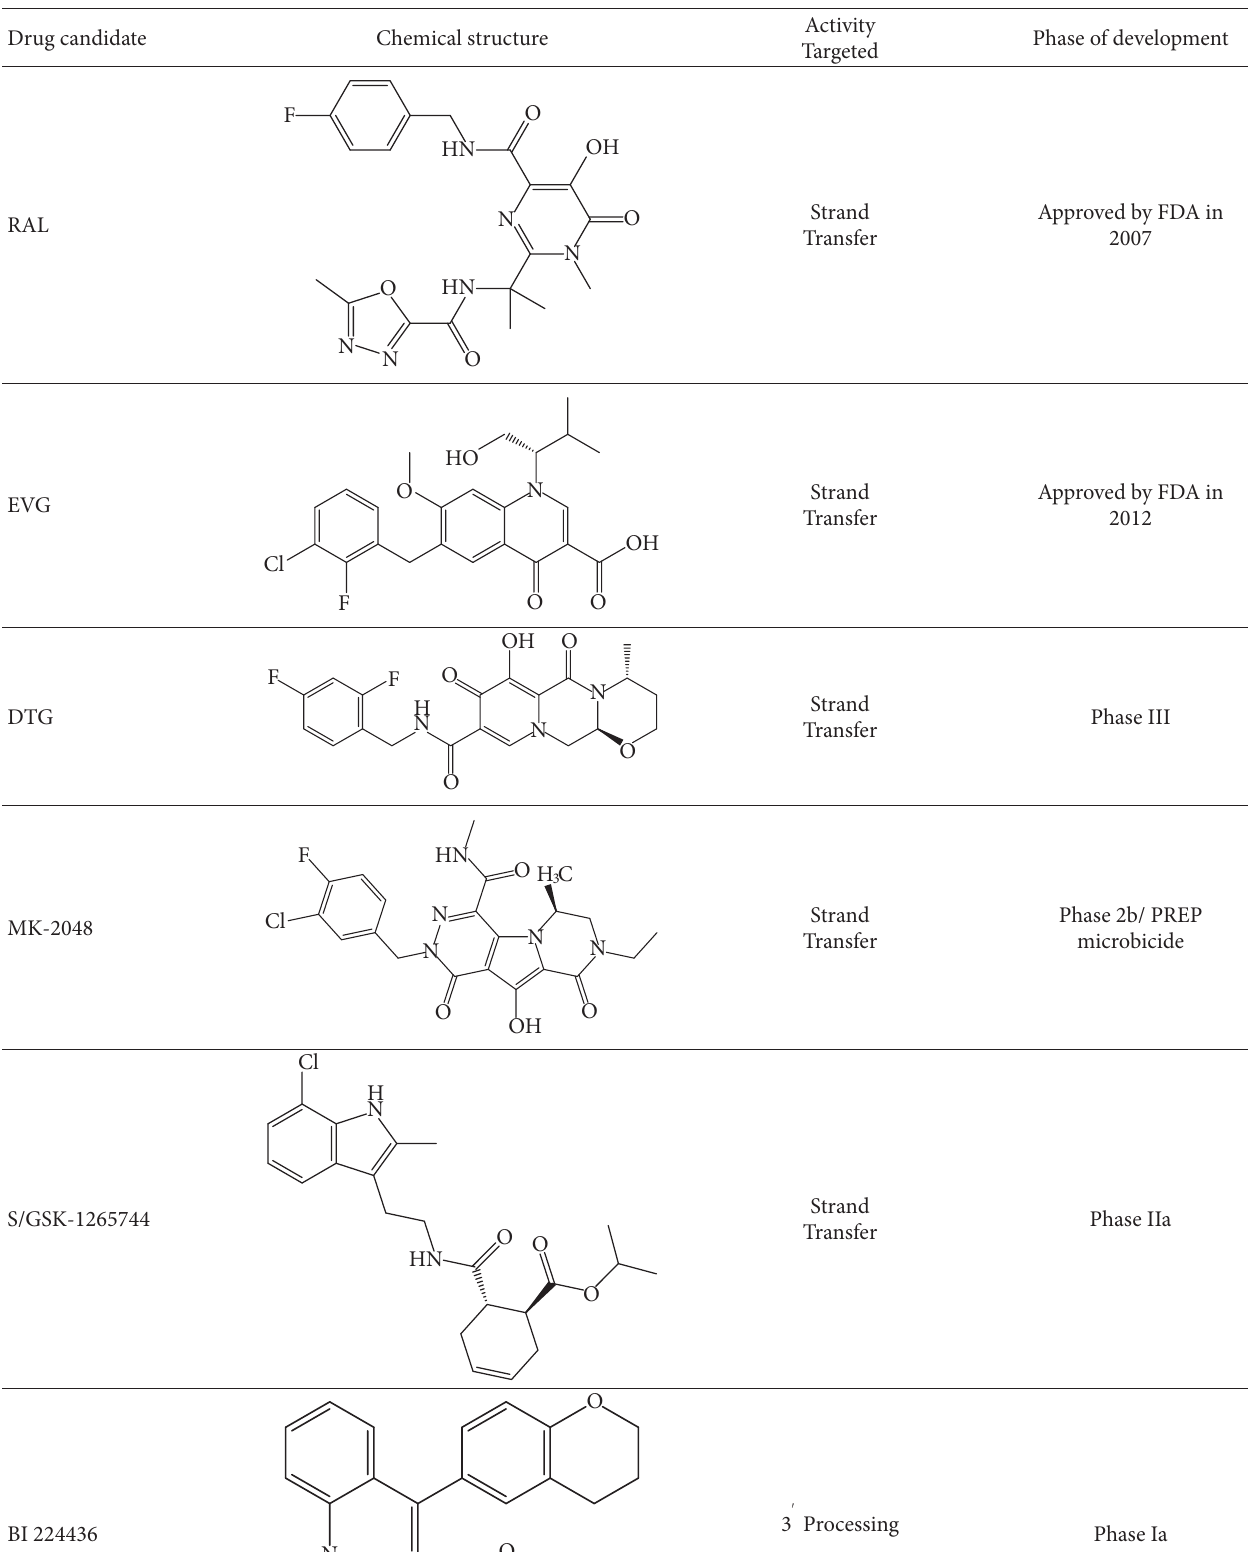
T 3: Clinically relevant INI compound